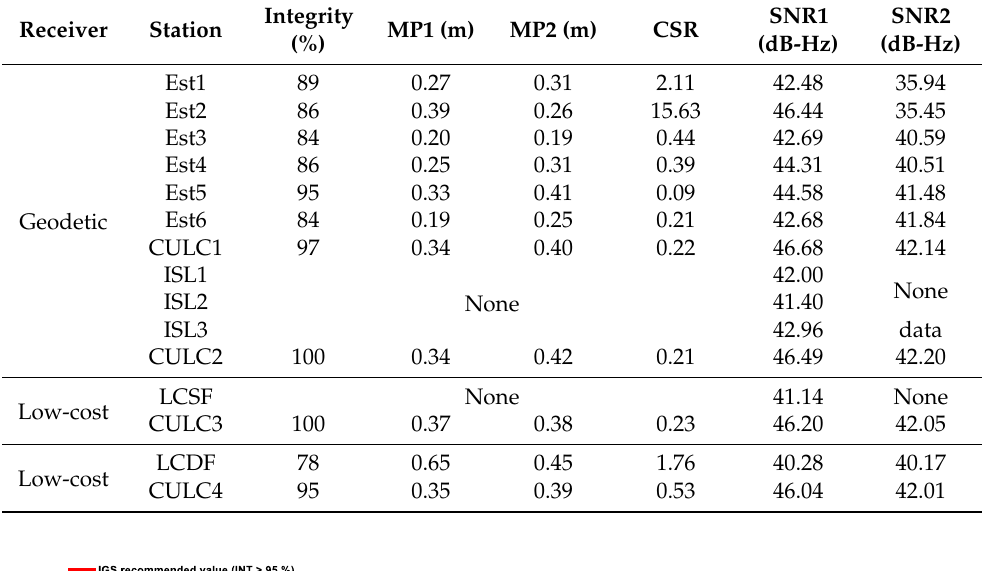
Table 5. Results of quality check of the GNSS observations results.